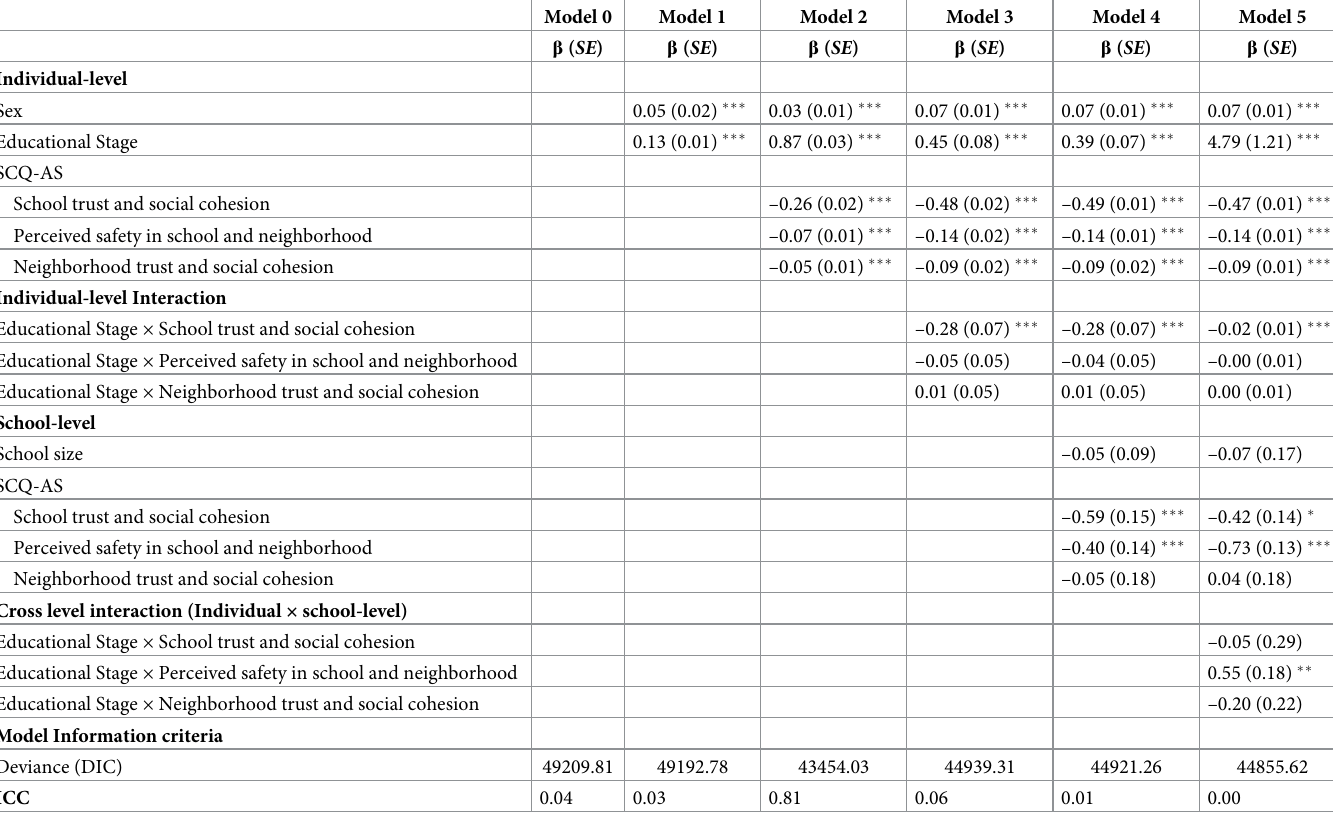
Table 2. Multilevel linear mixed effect model coefficients for